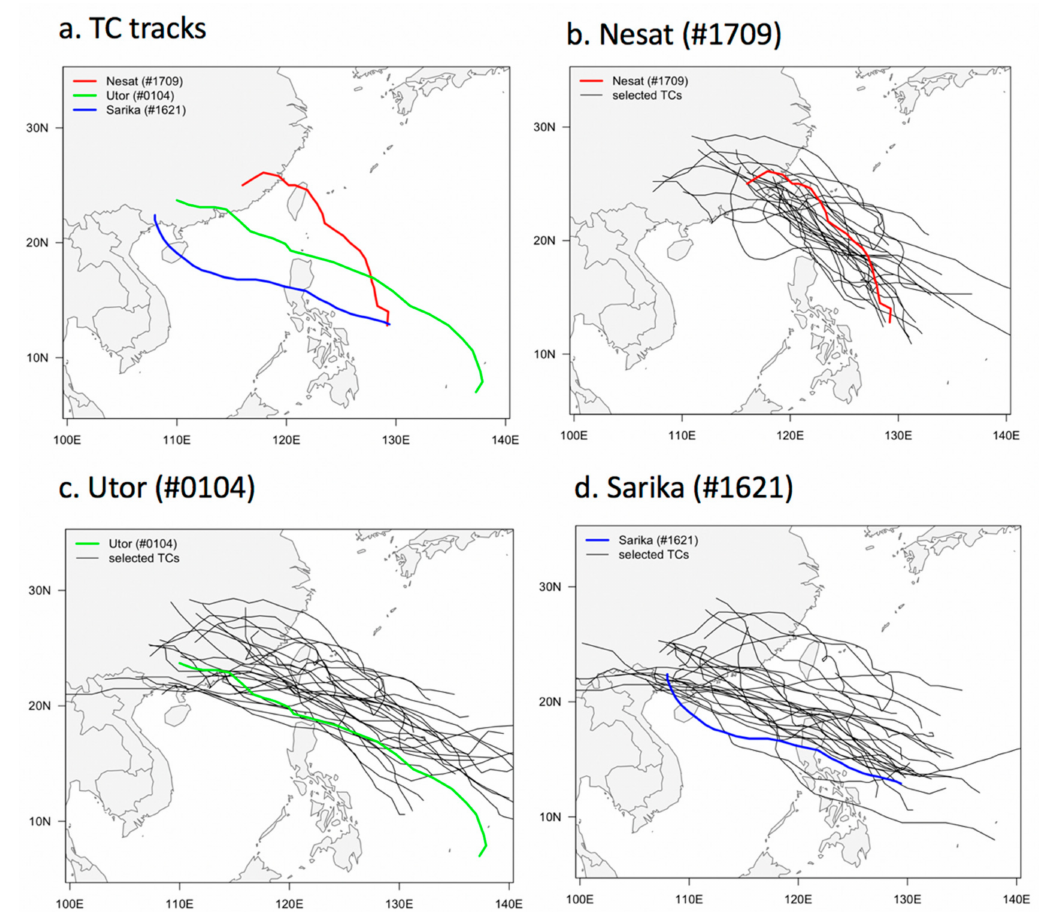
Figure 6. Verification of the prediction model established in the present study: ( a ) the TC tracks used; (b–d) the selected typhoon trajectories most similar to those of ( b ) typhoon Nesat (#1709); ( c ) typhoon Utor (#0104); and ( d ) typhoon Sarika (#1621). The typhoon numbers and similarity levels are indicated in the